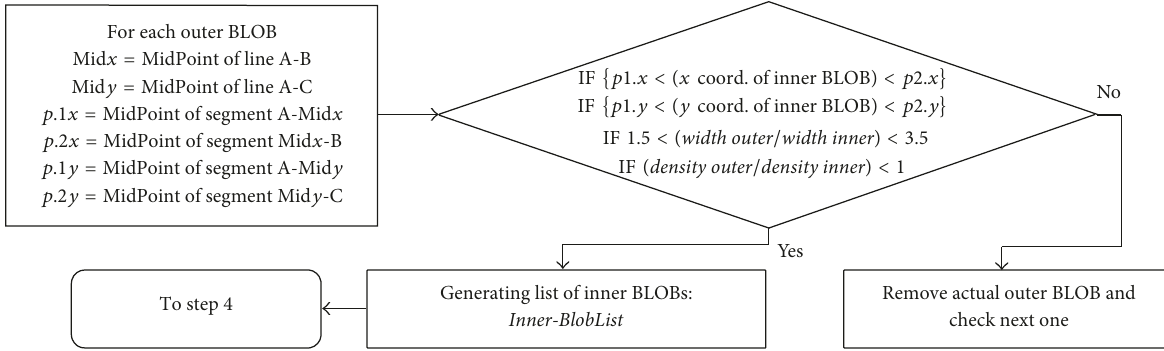
Figure 6: Step 3 : block diagram of algorithm for detecting groups of BLOBs, where inner BLOBs are surrounded by the biggest one.